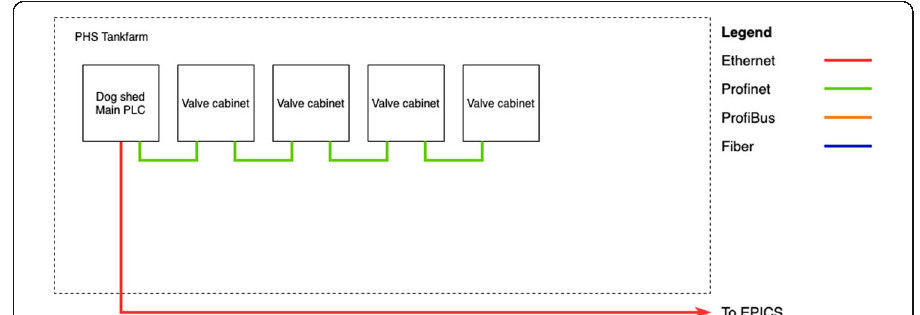
Fig. 12 Simplified control systems architecture PHS tank